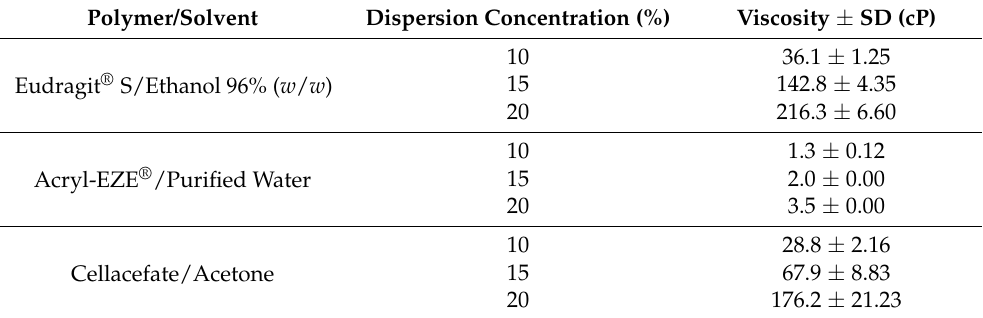
Table 2. The viscosity of polymer dispersions with a constant temperature of 26.0 ± 0.5 ◦ C. Polymer/Solvent Dispersion Concentration (%) Viscosity ± SD (cP) 10 Eudragit ® S/Ethanol 96% ( w / w )